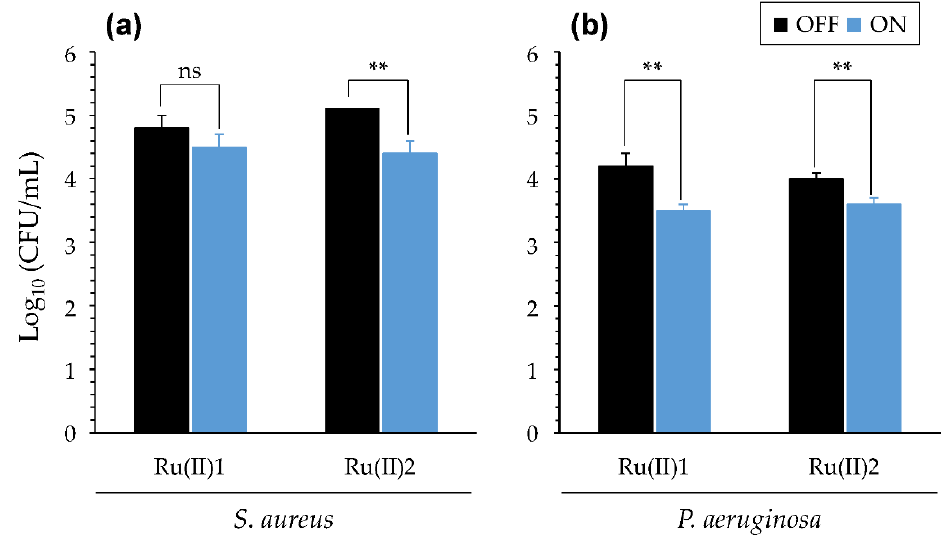
Figure 8. PDT effects of [Ru(II)] in ASM. Results were obtained with S. aureus RN4220 ( a ) and P. aeruginosa PA19660 ( b ) for prolonged irradiation. See Figure S8 for results obtained when using standard light treatment. [Ru(II)] concentration = 25 µM in 1X ASM. Mean SD with n = 3 and N = 2. **, p - value ≤ 0.01; “ns”: non -significant.